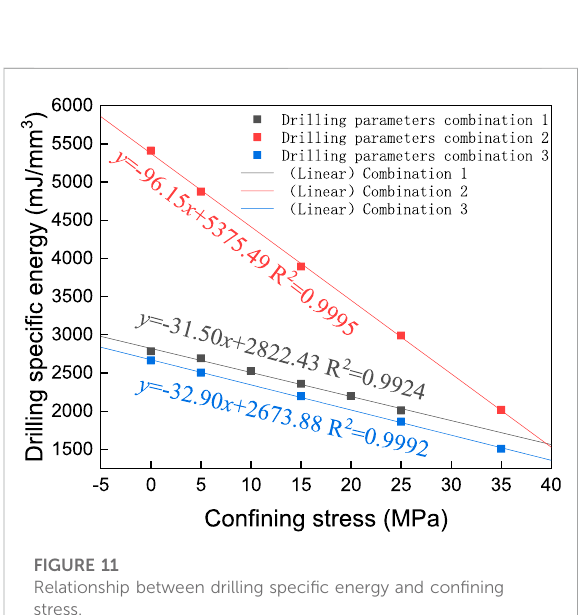
FIGURE 11 Relationship between drilling speci fi c energy and con fi ning